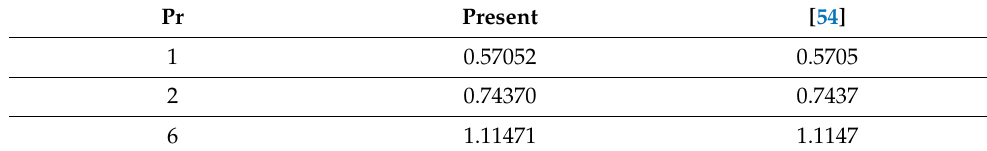
Table 3. Comparison of results for − θ (cid:48) ( 0 ) with numerical results in [54] when φ = 0 and β = 1. Pr Present